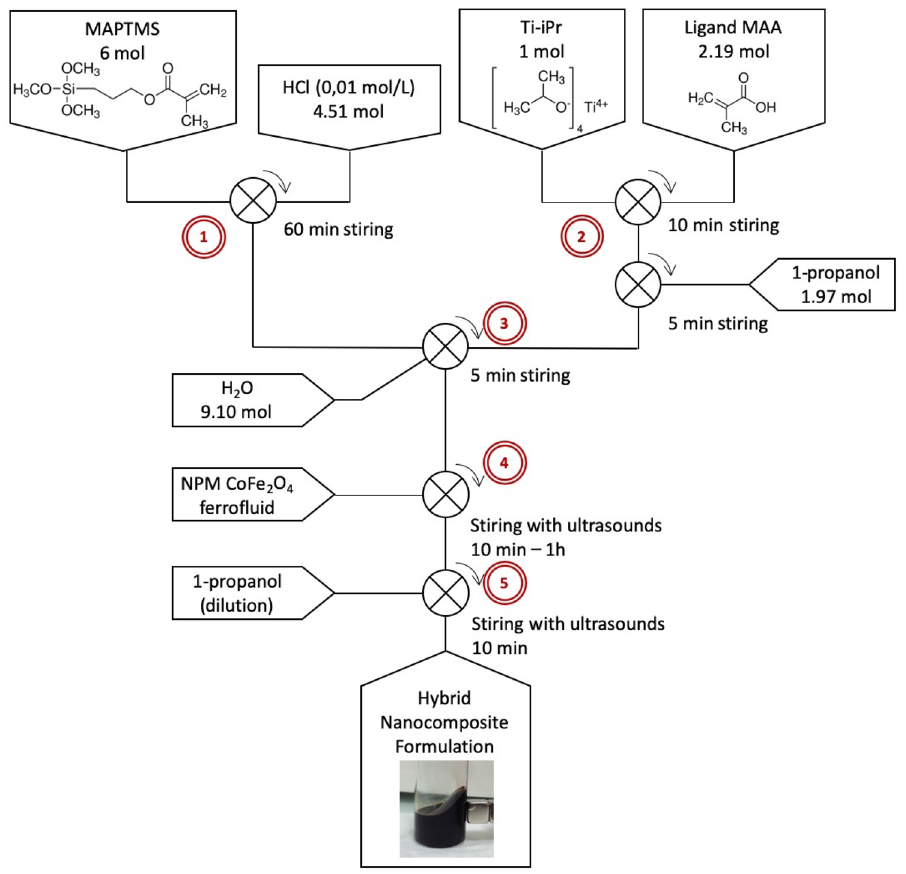
Figure 1. Schematic view of the preparation steps of the doped formulation, in 5 steps: 1) Pre-hydrolysis of MAPTMS, 2) Complexation of Ti precursor, 3) Hydrolysis-condensation reactions, 4) Doping of the sol–gel matrix by MNPs and 5) dilution of the formulation by